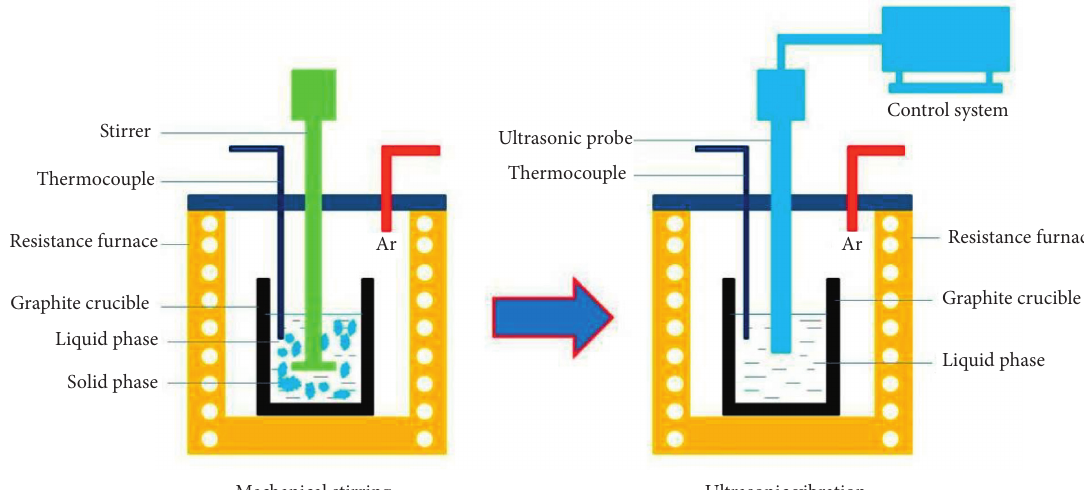
Figure 2: Schematic of the processing method for the nanocomposites.